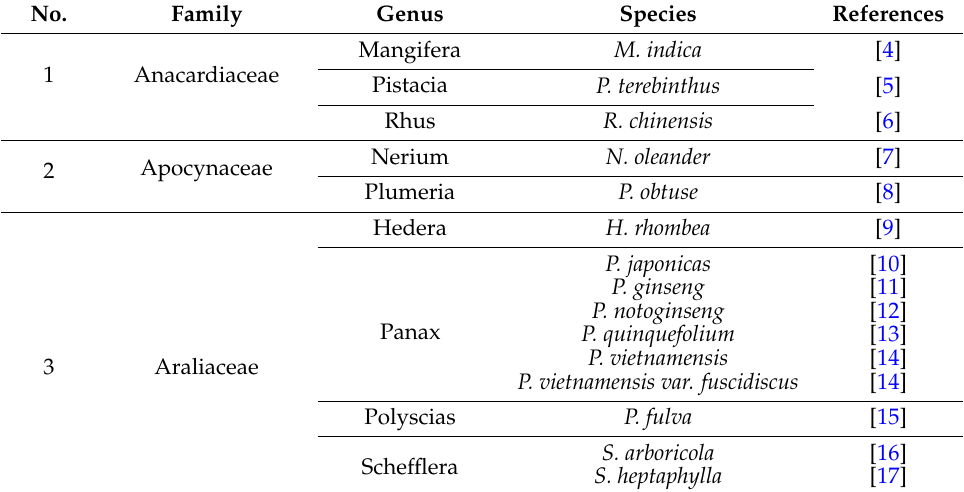
Table 1. Plant sources of DTT.